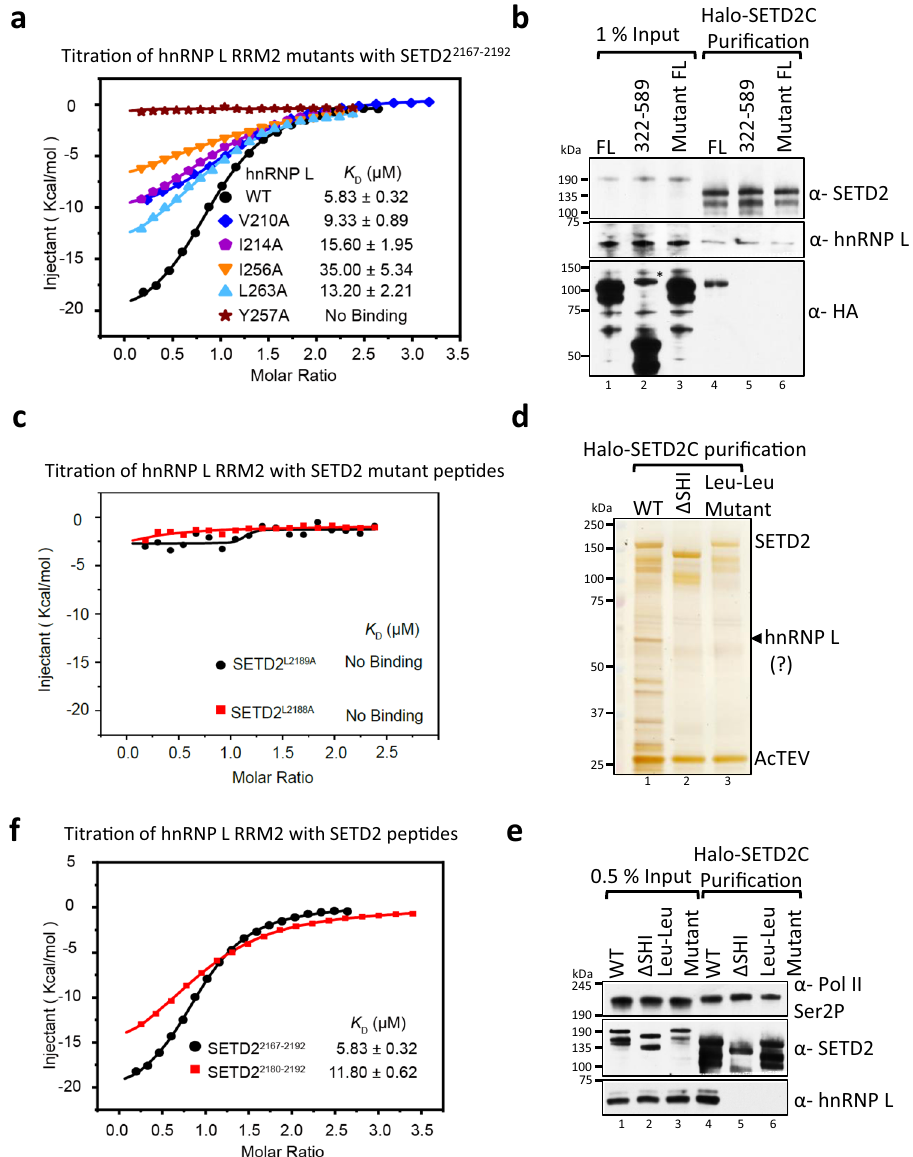
Fig. 5 Mutating key residues in hnRNP L and SETD2 disrupts their in vitro and in vivo binding. a ITC fi tting curves of hnRNP L RRM2 WT and mutants with SETD2 2167 – 2192 peptide are shown. b , d , e Western blotting and silver staining of af fi nity-puri fi ed complexes of Halo-SETD2C WT and its mutants. In ( b ), mCherry-HA-hnRNP L proteins were used as prey. * denotes non-speci fi c band. The experiment was repeated four times all yielding similar results. Source data are provided as a Source Data fi le. c , f ITC fi tting curves of hnRNP L RRM2 with SETD2 peptides. For the arithmetic mean of K D values of the three independent experiments and the thermodynamic parameters see Supplementary Table 1. All ITC binding curves are shown in